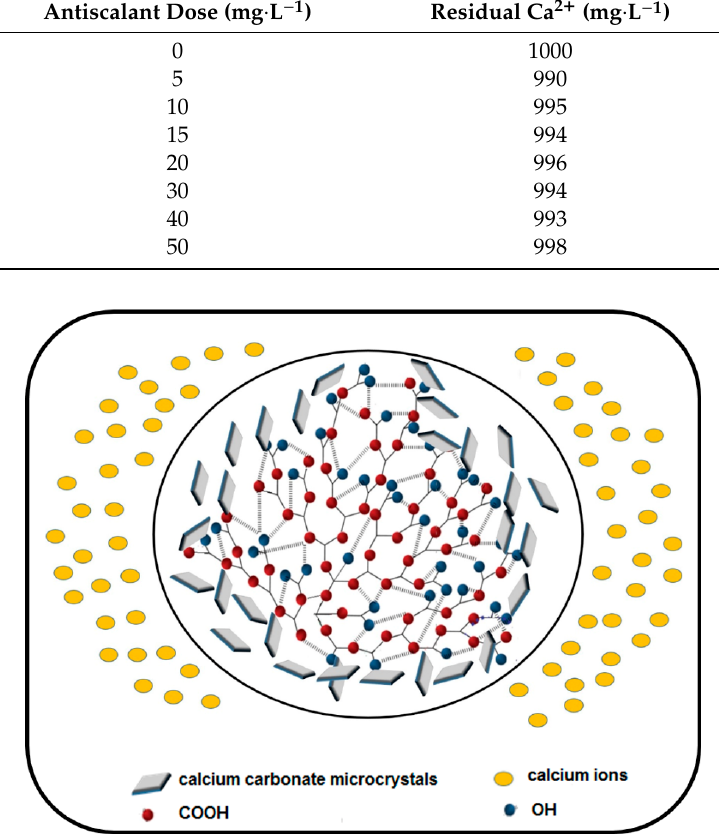
Table 1. Concentration of residual Ca 2+ after the incubation period at different CA-co-GLC